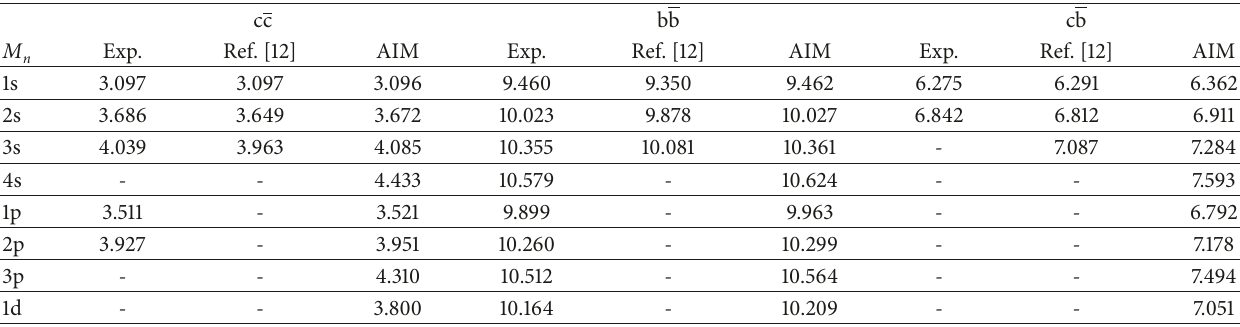
Table 7: Comparisons of the masses (in GeV), obtained via AIM, of the heavy mesons cc, bb, and cb with the ones of [12], and with the experimental data from [22]. In this case, we have taken the quark masses as 𝑚 𝑐 =1.44 GeV and 𝑚 𝑏 =4.87 GeV, and the potential parameters as 𝐴 = 0.64 and 𝐵 = 0.39 GeV, for our calculations. All these parameters have been obtained by fitting our formula, given in (28), to the experimental data. cc bb